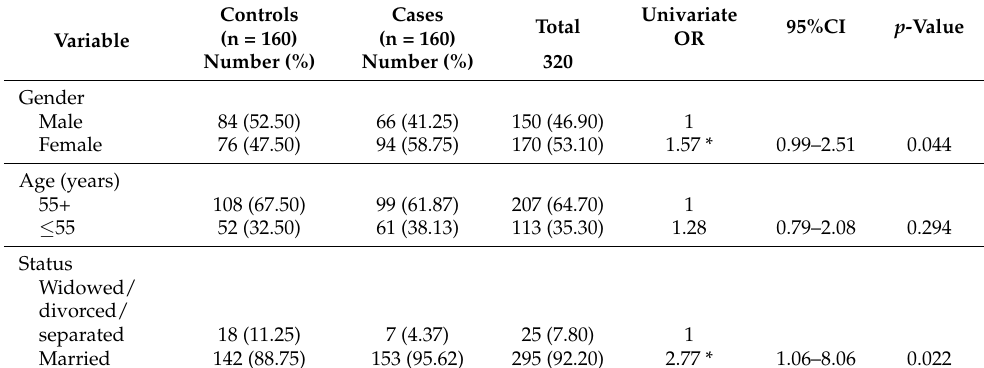
Table 1. Baseline characteristics of 320